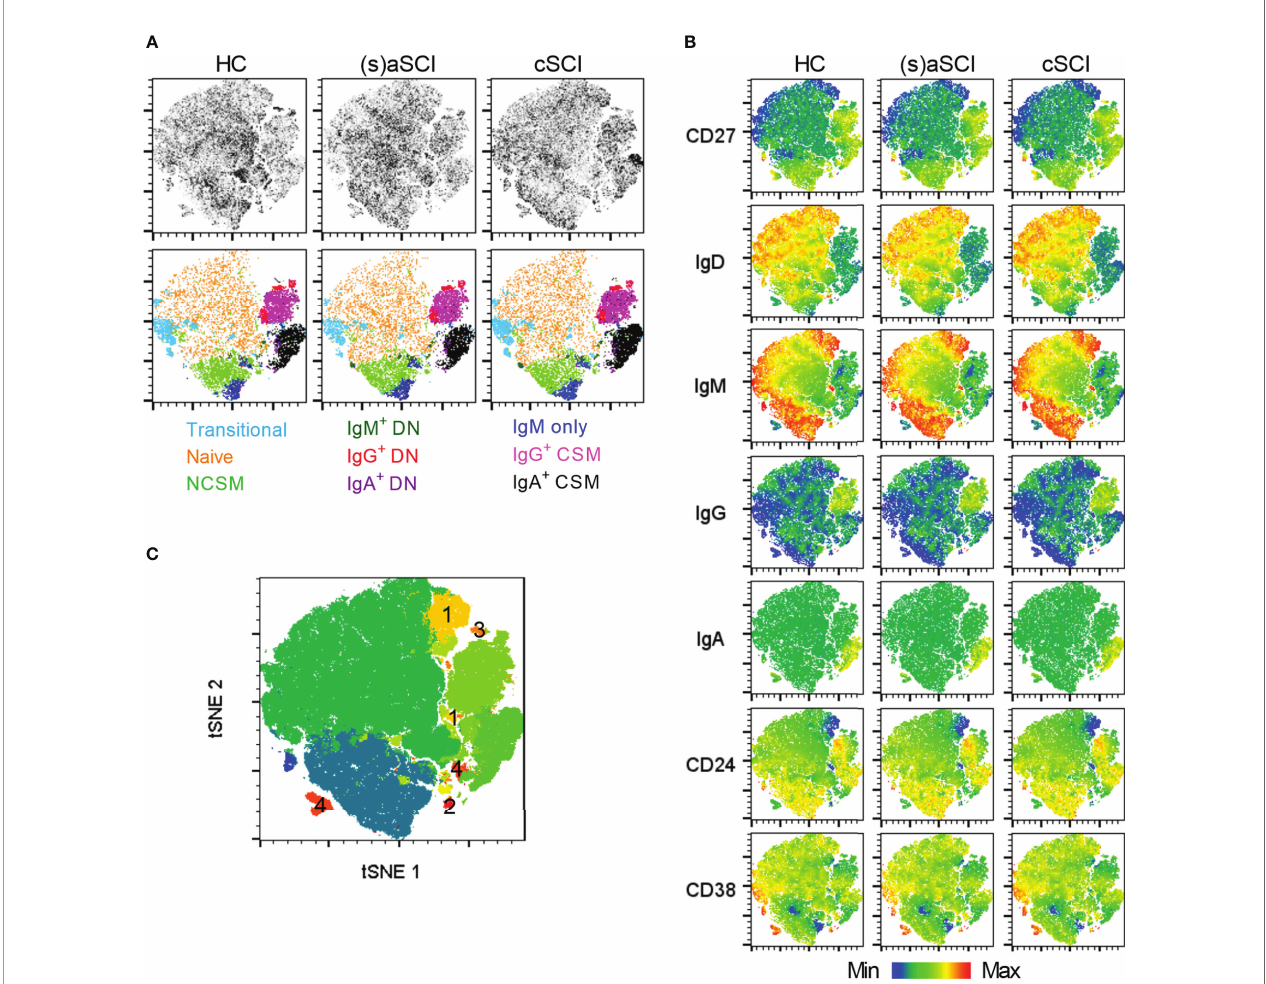
FIGURE 4 | High-dimensional fl ow cytometry of B cell subsets in the peripheral blood of HC and SCI patients. (A) tSNE map showing B cell subsets within the CD19 + B cell population of HC (n = 18) and SCI patients (n = 18), including (s)aSCI (17 samples) and cSCI (29 samples). In the upper row, tSNE maps are shown on a density plot while the lower row shows the manually determined gates on the tSNE maps. (B) Surface marker distribution is depicted in the tSNE map. Relative antigen expression is visualized by the color tone (from blue to red). (C) FlowSOM clusters are shown in the tSNE map as overlay. The clusters that were not included in our manual gating strategy are labelled from 1 to